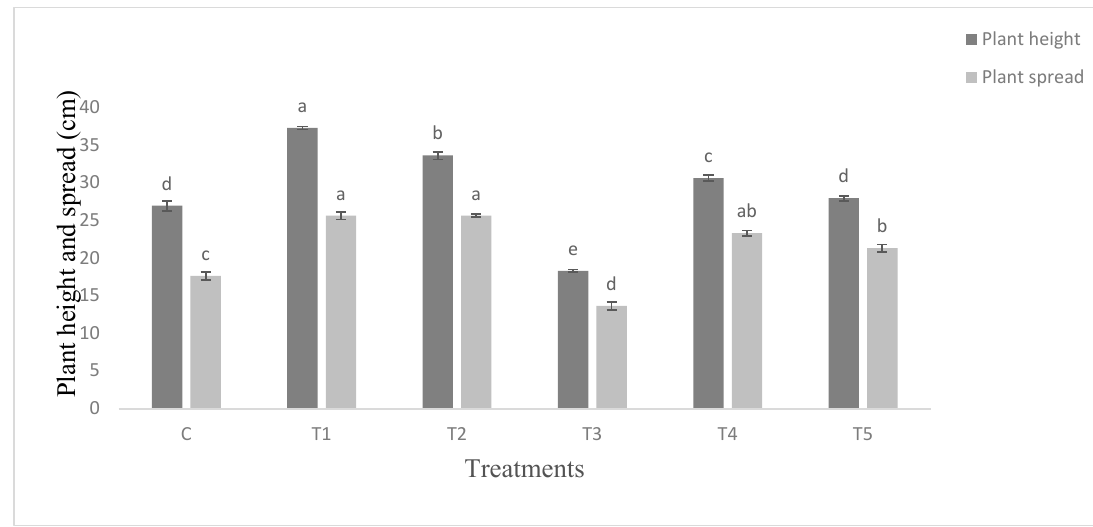
Figure 1. Mean plant height and plant spread (cm) of tomato under control and infested conditions. Data are means of four replicates along with standard error bars. Different letters on the bar represent significant differences ( p < 0.05) among treatments.